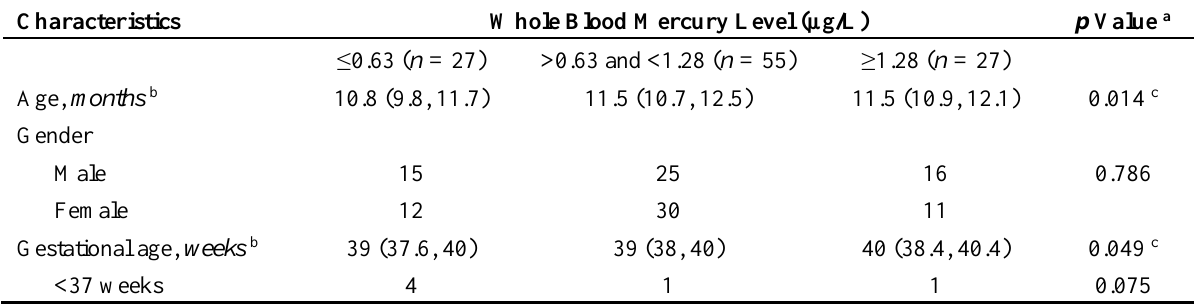
Table S1. Demographic, anthropometric, and diet-related parameters and iron status in three categories of infants according to the quartile values of whole blood mercury